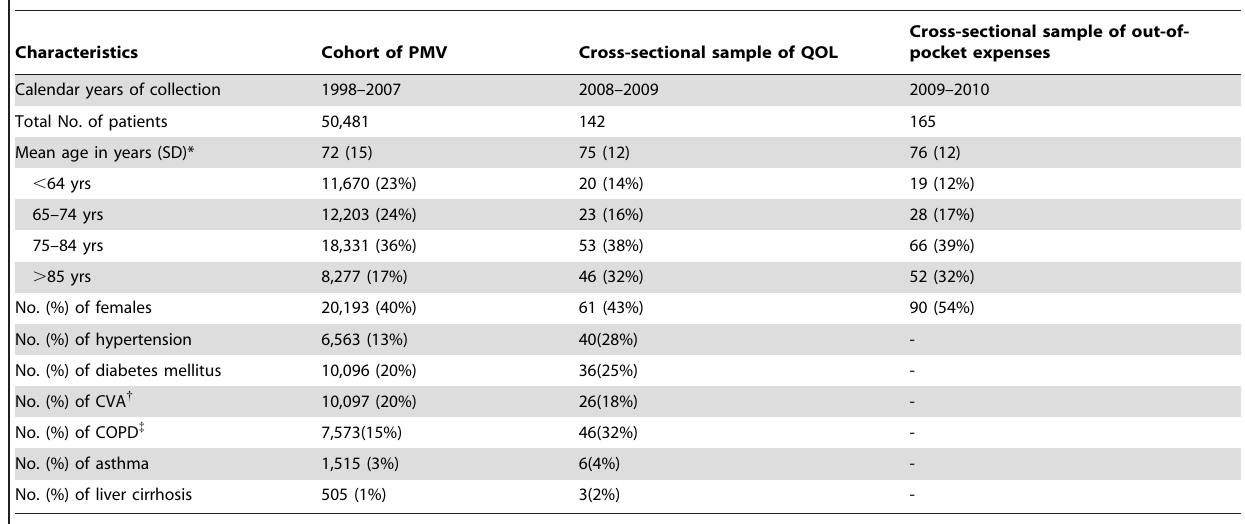
Table 1. Characteristics of patients undergoing prolonged mechanical ventilation (PMV) and 2 cross-sectional samples for assessing quality of life (QOL) and out-of-pocket